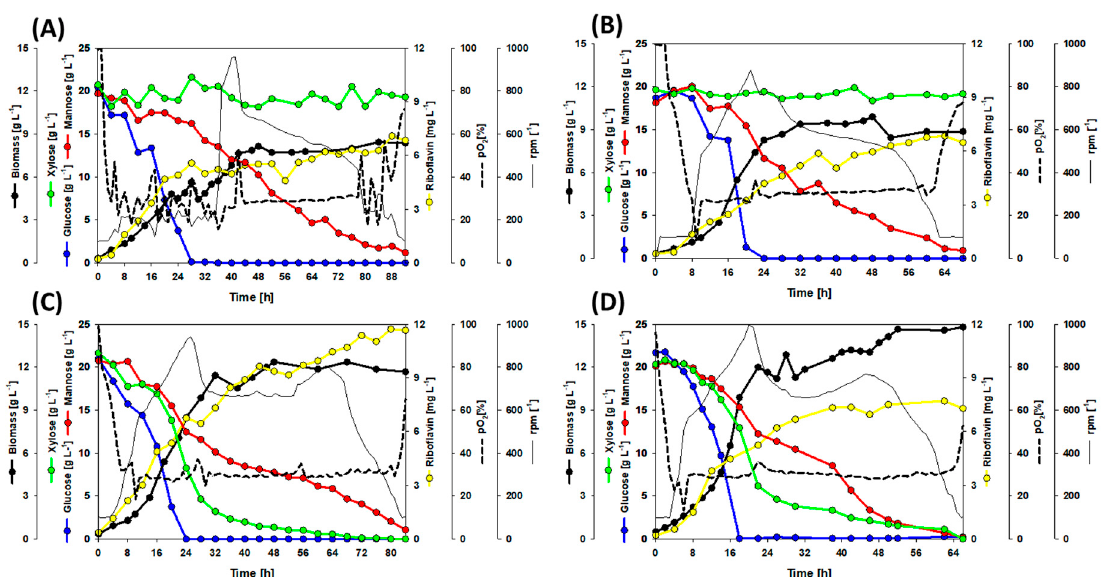
Figure 3. Bioreactor batch fermentations with 60 g L − 1 synSSL as sole carbon source. ( A ) Growth and production of the strain RiboGlu. ( B ) Growth and production of the strain RiboMan. ( C ) Growth and production of the strain RiboXyl. ( D ) Growth and production of the strain RiboSSL. Data is depicted as follows: glucose consumption (blue line), mannose consumption (red line), xylose consumption (green line), riboflavin accumulation (yellow line), biomass formation (thick black line), stirring profile (thin black line), and pO 2 profile (dotted line). One replication of each cultivation was carried out. Table 4. Growth and production values of various riboflavin producing strains in bioreactor batch cultivation with 20 g L −